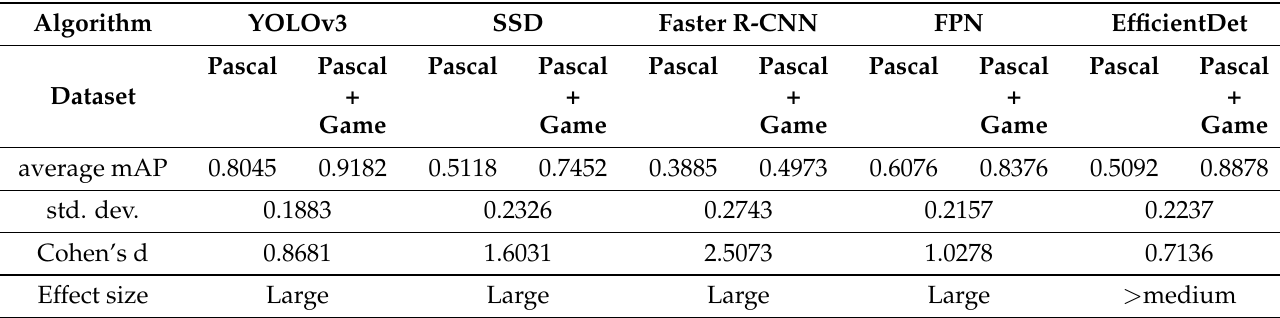
Table 10. Cohen’s d values for mAPs from five object detection algorithms. We compared the algorithms trained by PascalVOC and retrained by PascalVOC with game scenes. Note that PascalVOC is abbreviated as Pascal in the table. Algorithm